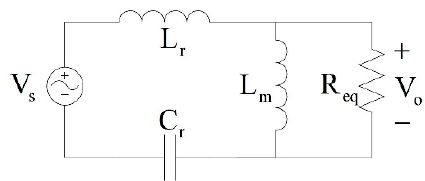
Figure 3. Equivalent circuit of LLC resonant converter.